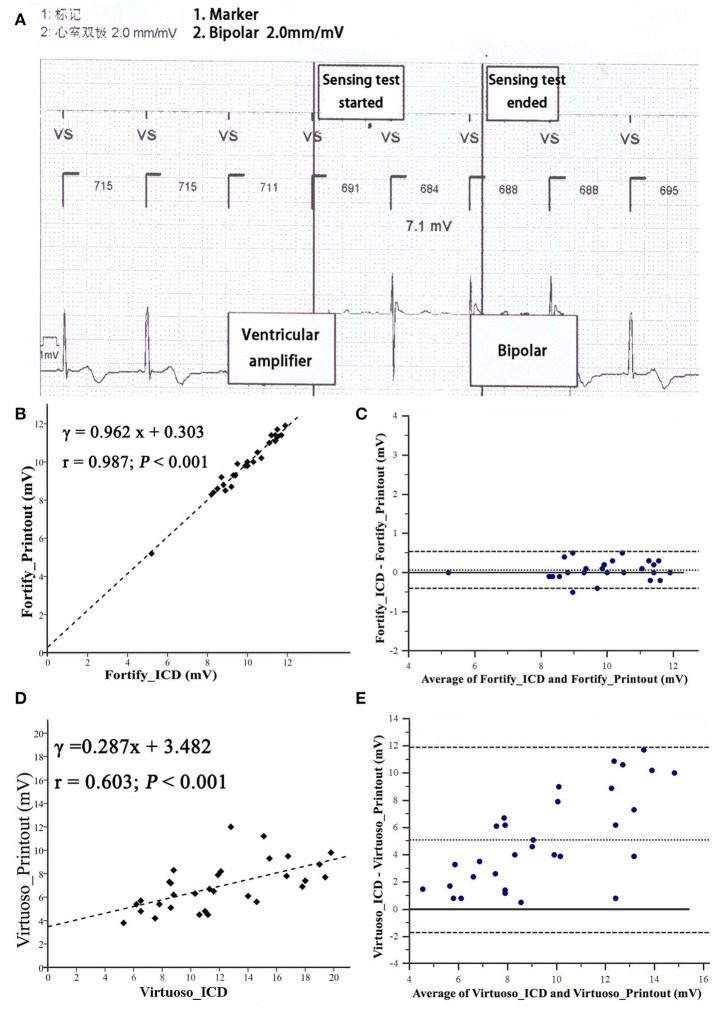
Bland-Altman analysis comparing R wave amplitudes measured from implantable cardioverter-defibrillator printouts. (A) Measurement of R wave amplitude by Fortify ICD. Noted that IEGM of ICD automatically switched to “Ventricular amplifier” channel to measure R wave amplitude. (B,C) R wave amplitude measured from by Fortify ICD. (D,E) R wave amplitude measured by Virtuoso ICD. Inner dashed line is the mean difference; outer dashed lines are mean ± 1.96 SD.